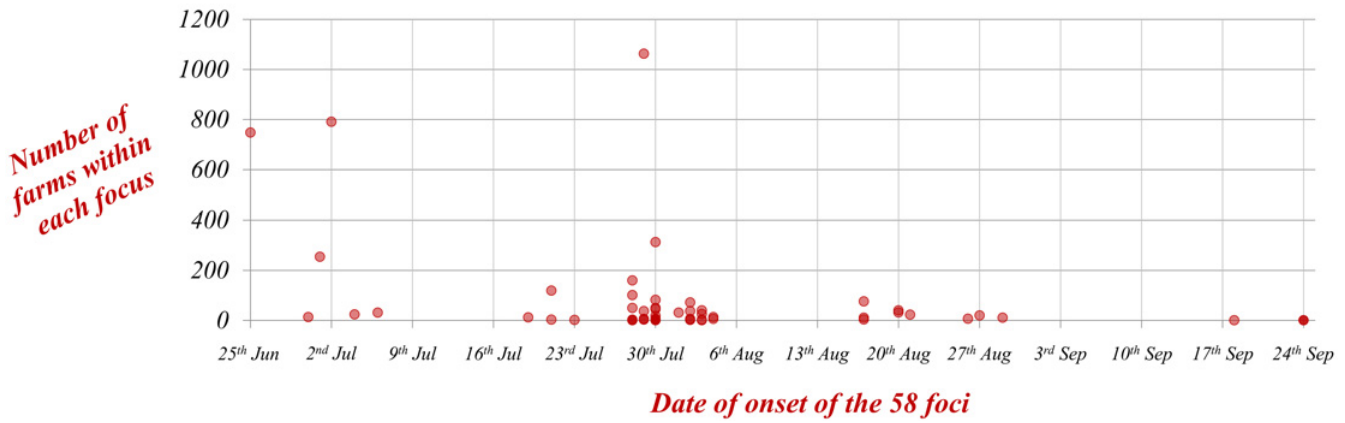
Fig 3. Number of infected farms within each of the 58 disease foci depending on the date of onset of the foci.